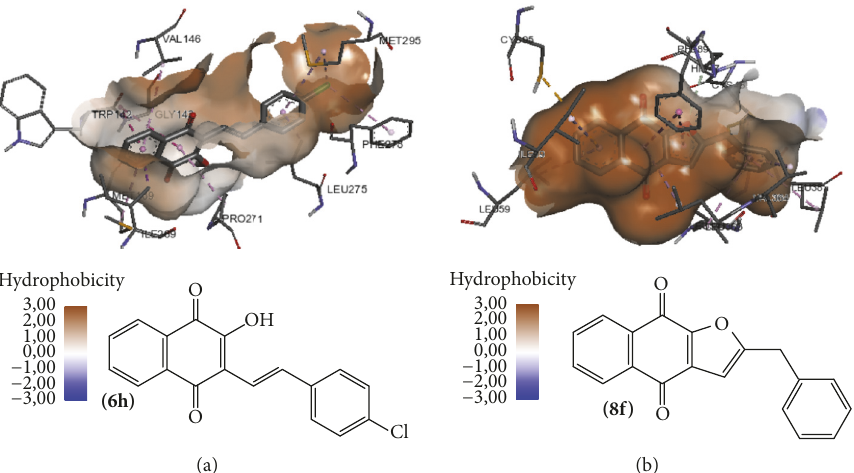
Figure 4: (a) Compound 6h complexed into the hydrophobic surface of 4PD4. (b) Compound 8 f complexed into the hydrophobic surface of 5FI8.